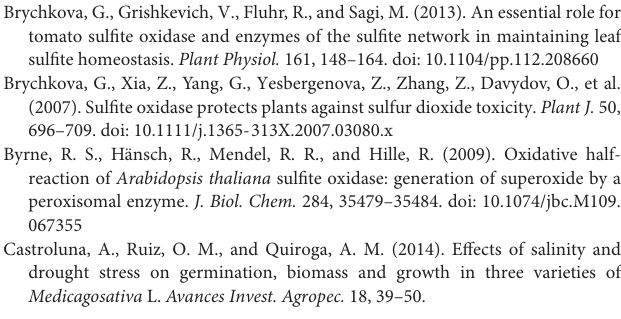
FIGURE S1 | The proportion of open stomata in the wild-type (WT) and ZmSO - overexpressing tobacco lines under water stress. The proportion of open stomata was determined by the number of open stomata to that of stomata counted in epidermal peels from leaves of WT and both OE (OE-3 and OE-7) plants upon 9 days of control and drought stress. Bar indicates SE. ∗∗ t -test, with P < 0.01. TABLE S1 | qPCR primers used in this